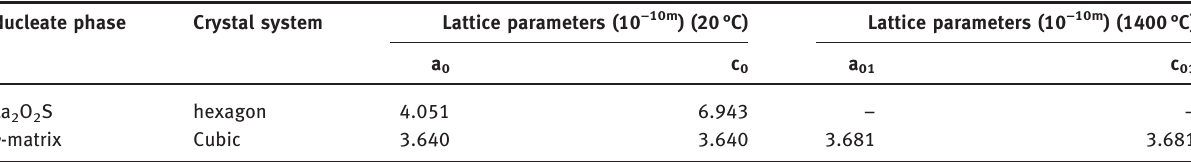
Table 2: Crystallographic data of La 2 O 2 S and γ -matrix. Nucleate